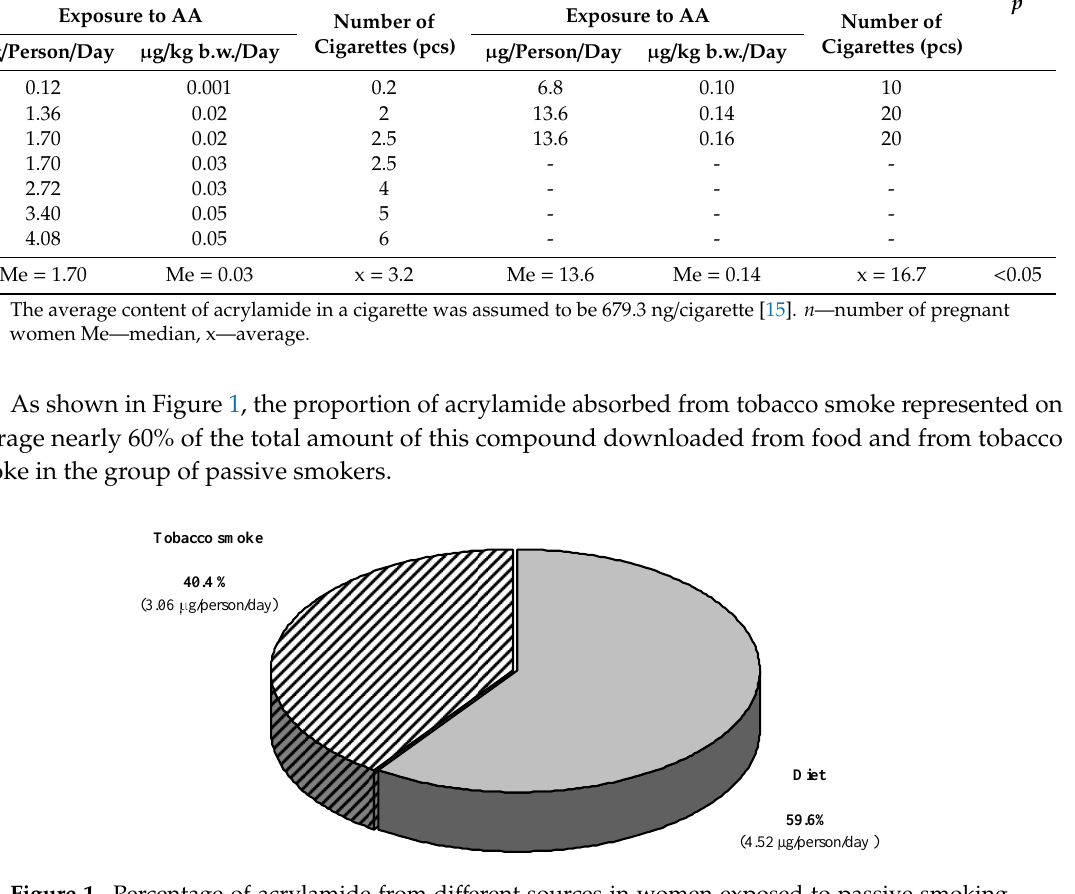
Figure 1. Percentage of acrylamide from di ff erent sources in women exposed to passive smoking. ( n = 10).